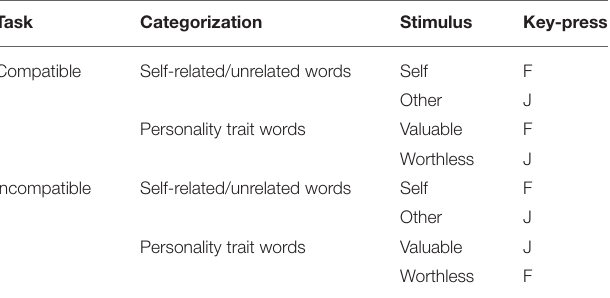
TABLE 1 | Illustration of the self-evaluation Implicit Association Task